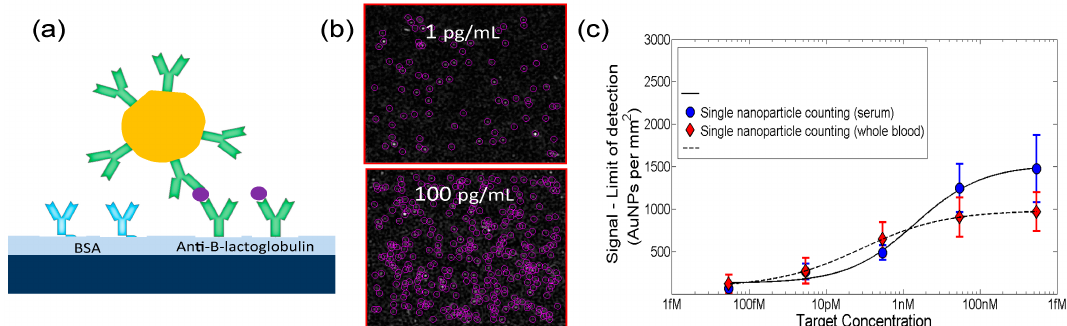
Figure 2. ( a ) Conceptual representation of SP-IRIS single molecule counting assay for protein biomarker detection; ( b ) Representative images at 1 pg/mL and 100 pg/mL target concentration; ( c ) Dilution curve for β -lactoglobulin in unprocessed serum and whole blood. Adapted with permission from Ref. [51]. Copyright (2013) American Chemical